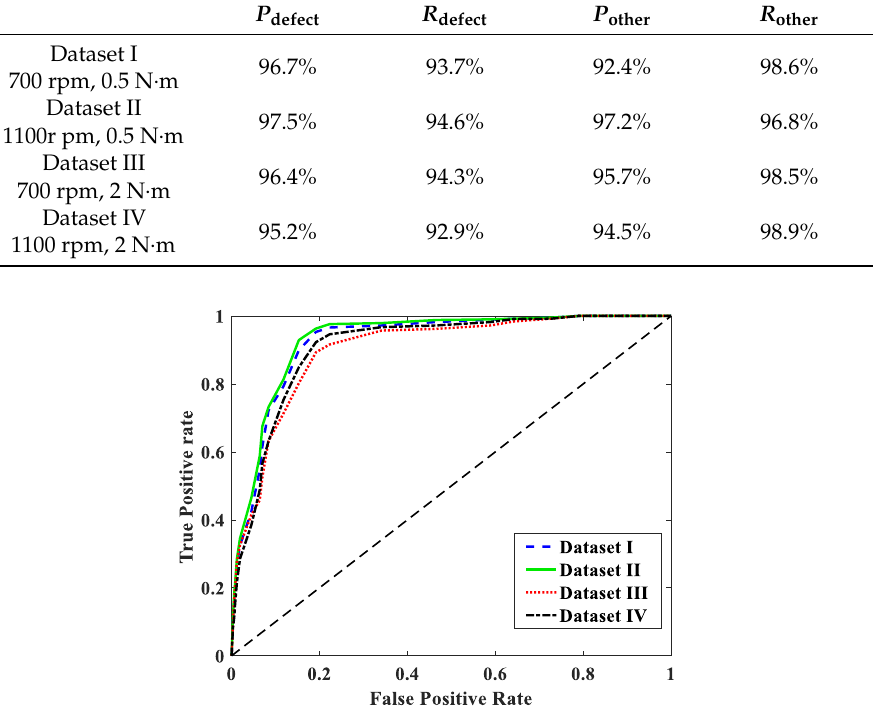
Figure 8. Receiver operating characteristic (ROC) curve for the four different datasets. Energies 2019 , 12 , x FOR PEER REVIEW